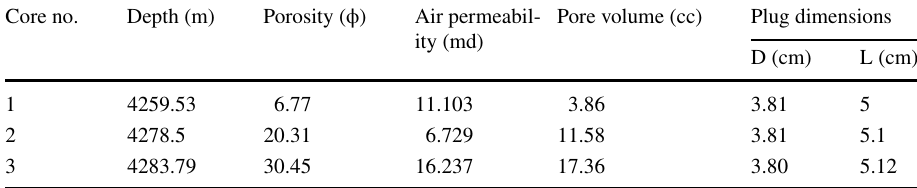
Table 2 Petrophysical properties of the core samples